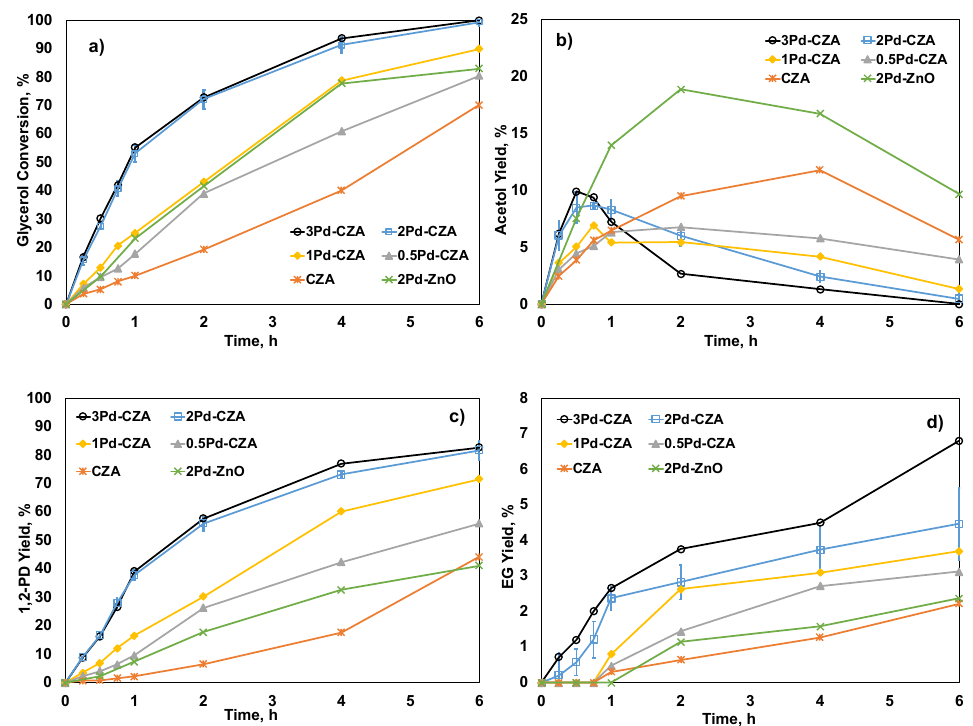
Figure 6. Glycerol conversion and yields of different products over the reaction time using the Cu/ZnO/Al 2 O 3 catalysts with different amounts of Pd loaded: ( a ) glycerol conversion; ( b ) acetol yield; ( c ) 1,2-PD yield; ( d ) EG yield. Reaction conditions: 220 ◦ C, 1.5 MPa N 2 , 20 wt% glycerol, water/methanol molar ratio = 1.2, 3 wt% catalyst with respect to total feed mixture, 6 h reaction time, 500 RPM. CZA: Cu/Zn/Al (molar) = 35/35/30. Error bars: 95% CI.